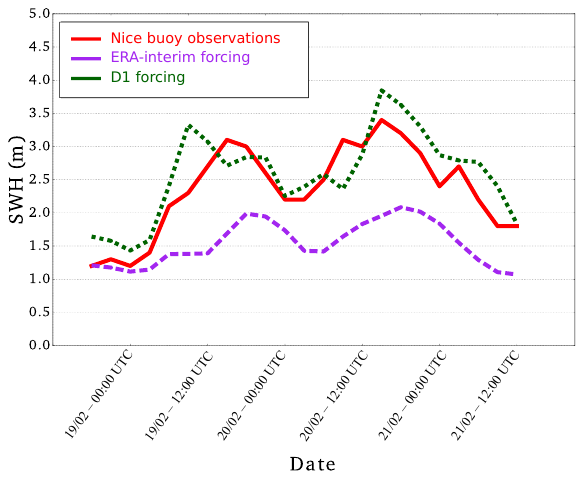
Figure 7. Time series of significant wave heights (SWHs) for the storm on February 2010 near Nice (43 ◦ 24 (cid:48) 0 (cid:48)(cid:48) N, 7 ◦ 48 (cid:48) 0 (cid:48)(cid:48) E) in the Mediterranean Sea. Purple and green stand for ERA-Interim and D1 forcing, respectively. The red line shows the time series of the Nice buoy